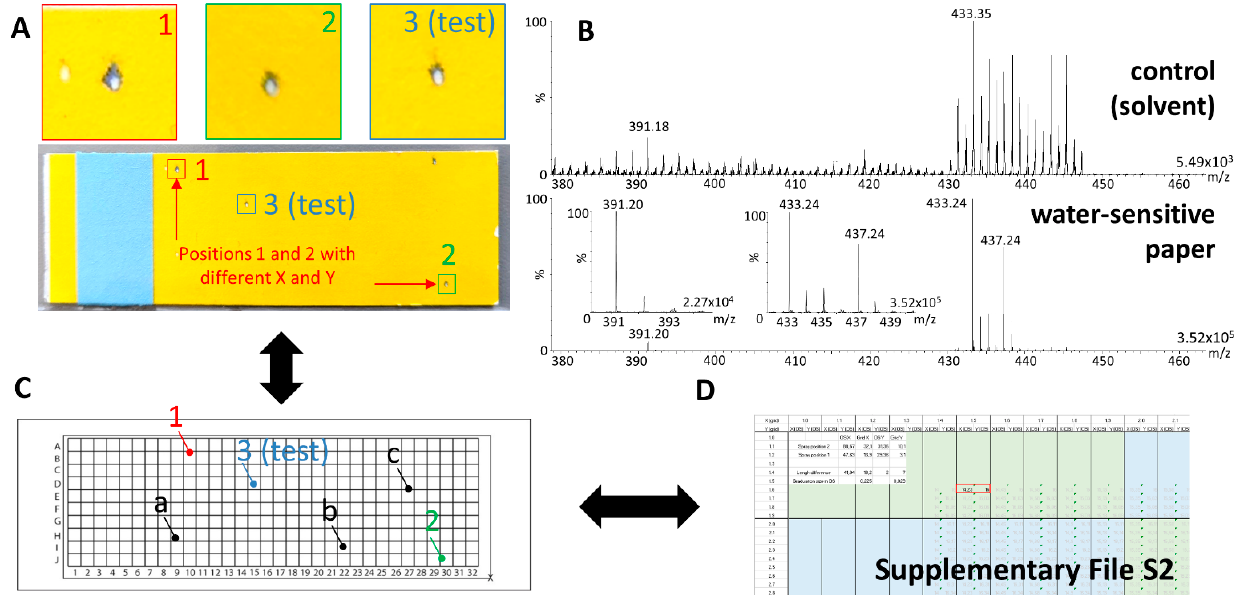
Figure 8. Desorption pattern evaluation, mass spectrometric signal adjustment, and sample position localization. ( A ) Typical desorption impact patterns using the High-Performance DESI Sprayer. Teaching points in 1 and 2, and a test point in 3 are created and respective x and y positions reported in Omnispray; ( B ) mass spectrometric signal obtained from water-sensitive paper with zooms on m / z 433.24 and m / z 391.19; ( C ) teaching and test x and y positions are reported in a grid and positions from the grid reported as well as positions of spots in samples (a, b, c); ( D ) Omnispray and grid x and y positions from teaching points are reported in an Excel file converting x and y grid positions into x and y Omnispray positions (Supplementary File S2). The precision of x and y Omnispray positions of the test point is verified in the Excel file as described in the standard operating procedure in the first table of Supplementary File S2; x and y Omnispray positions of samples are obtained by reading their equivalence from their x and y grid positions in the Excel file.